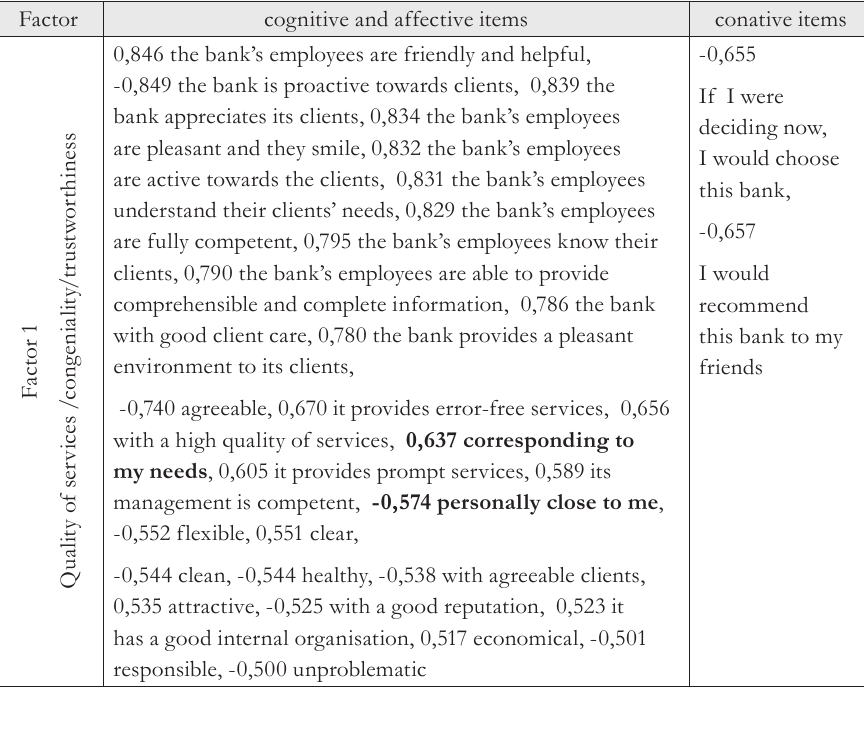
Tab. 8 - Bank 4: A description of the content of the extracted factors. Source: